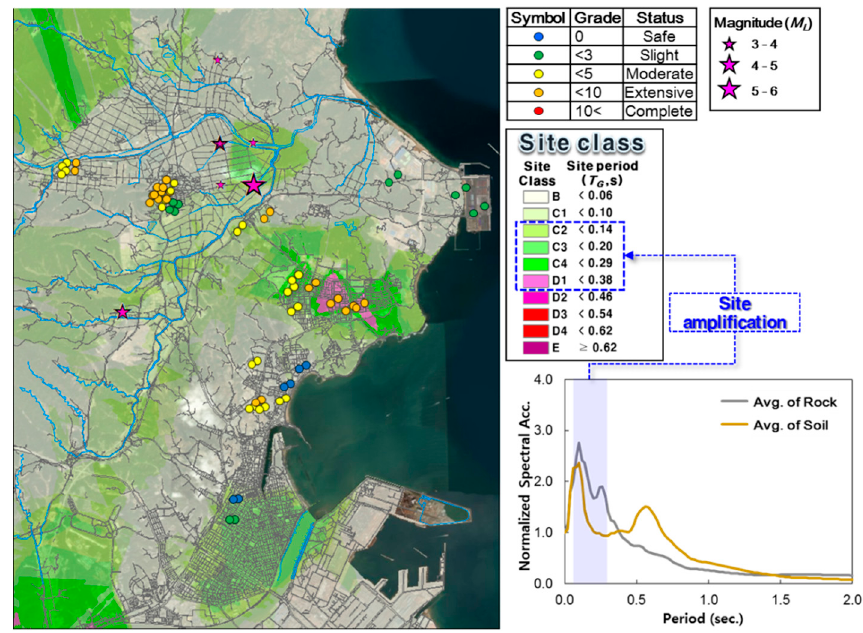
Figure 9. Spatial comparison between T G -based seismic zonation and earthquake damage category of buildings.